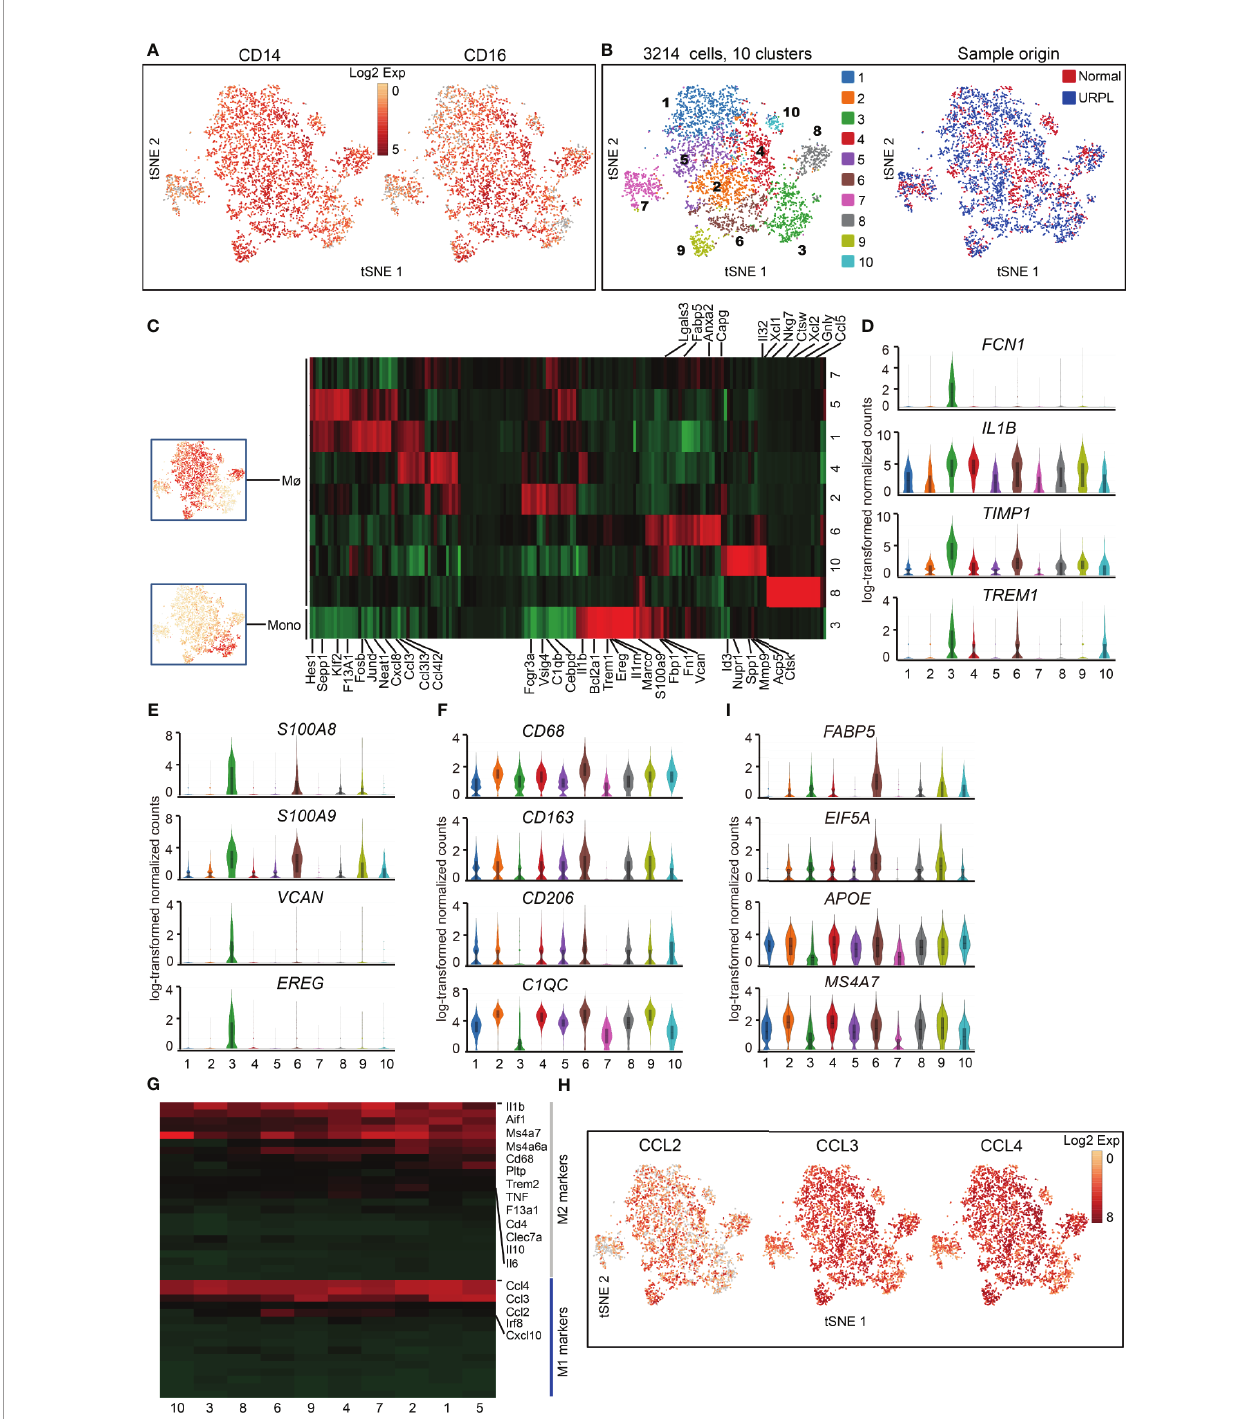
FIGURE 5 | Single-cell data revealed molecular details and subclusters of macrophages in decidua. (A) tSNE plot colorcoded for expression (gray to red) of CD14 and CD16. (B) tSNE of the monocyte, Mø as de fi ned in Figure 1A , with each cell colorcoded for (left to right): the associated cell type and its sample type of origin (normal or URPL). (C) Heatmap of enriched genes expression within de fi ned subclusters above. Expression is measured in units of log2. (D – F) Violin plots showing the smoothened expression distribution of differentially expressed genes speci fi c for monocyte, Mø subpopulations. (G) Heatmap of gene expression of M1 and M2 feature genes within de fi ned subpopulations. Gene expression was measured in units of log2. (H) tSNE visualization showed the expression of indicated genes. (I) Violin plots showing the smoothened expression distribution of differentially expressed genes speci fi c in cluster 6 macrophages. Analysis of gene expression in scRNA-seq data was performed in R (version 3.5.2) using